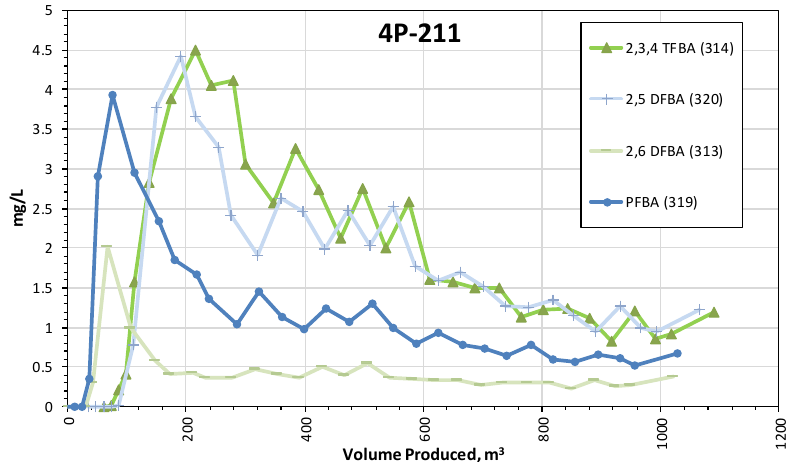
Figure A8. Tracer breakthrough curves as a function of volume produced in well 4P-211. Legend indicates number of the well into which each tracer was injected.